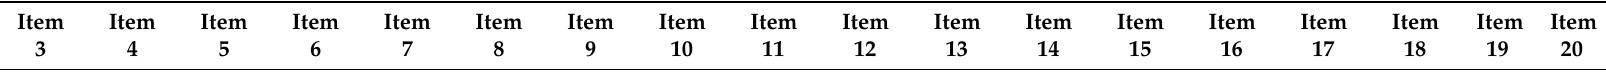
Table A1. Polychoric Correlation Coefficient Test on Items of